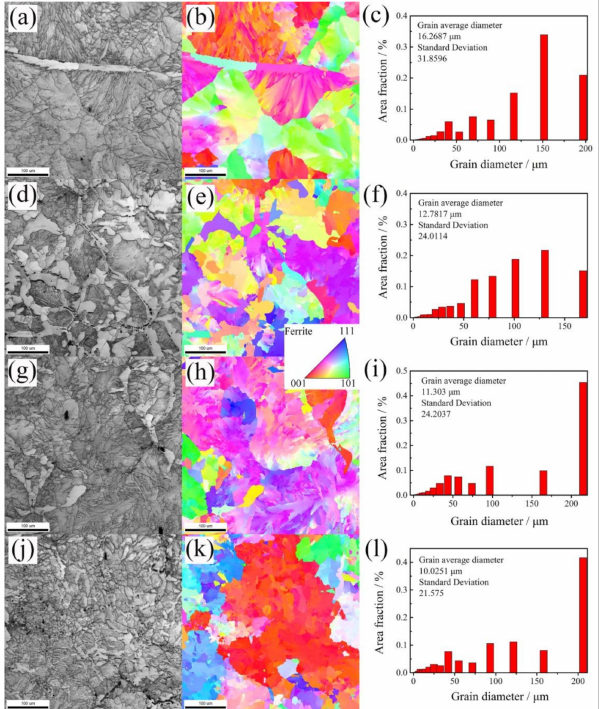
Figure 3. Image quality (IQ) map, inverse pole figure (IPF), and grain diameter statistic. ( a – c ) for steel A; ( d – f ) for steel B; ( g – i ) for steel C; ( j – l ) for steel D; respectively.